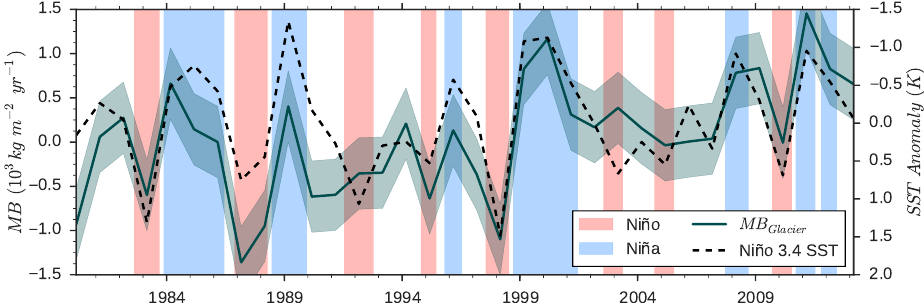
Figure 11. Same as Fig. 8 but for the glacier averaged MB. The shading represents ± 2RMSE. Note that this mass balance does not account for changing glacier geometry.